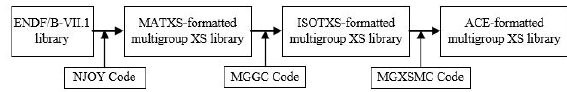
Figure 1. Procedure of generating multigroup XS Library in ACE